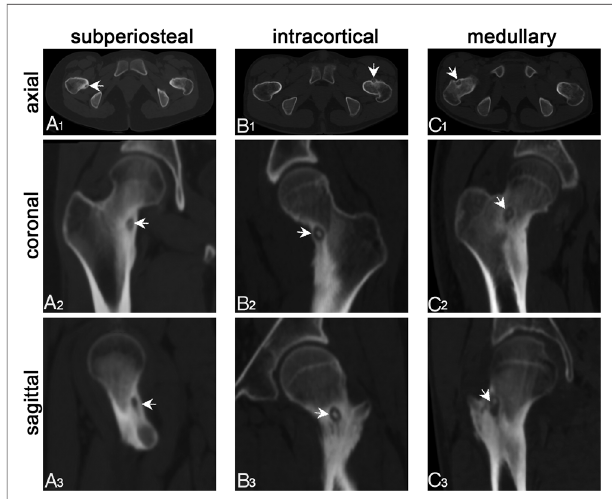
FIGURE 1 | Oo was classi fi ed into sub-periosteal, intra-cortical, and medullary type based on the location of the nidus using thin-layer CT. ( A1 – A3 ) Sub-periosteal: the nidus is located under the periosteum and outside the cortex; ( B1 – B3 ) intra-cortical: the nidus is located inside the bone cortex and expands inwards and outwards; ( C1 – C3 ) medullary: the nidus is completely intramedullary. The white arrow shows the nidus, some of which have high-density calci fi